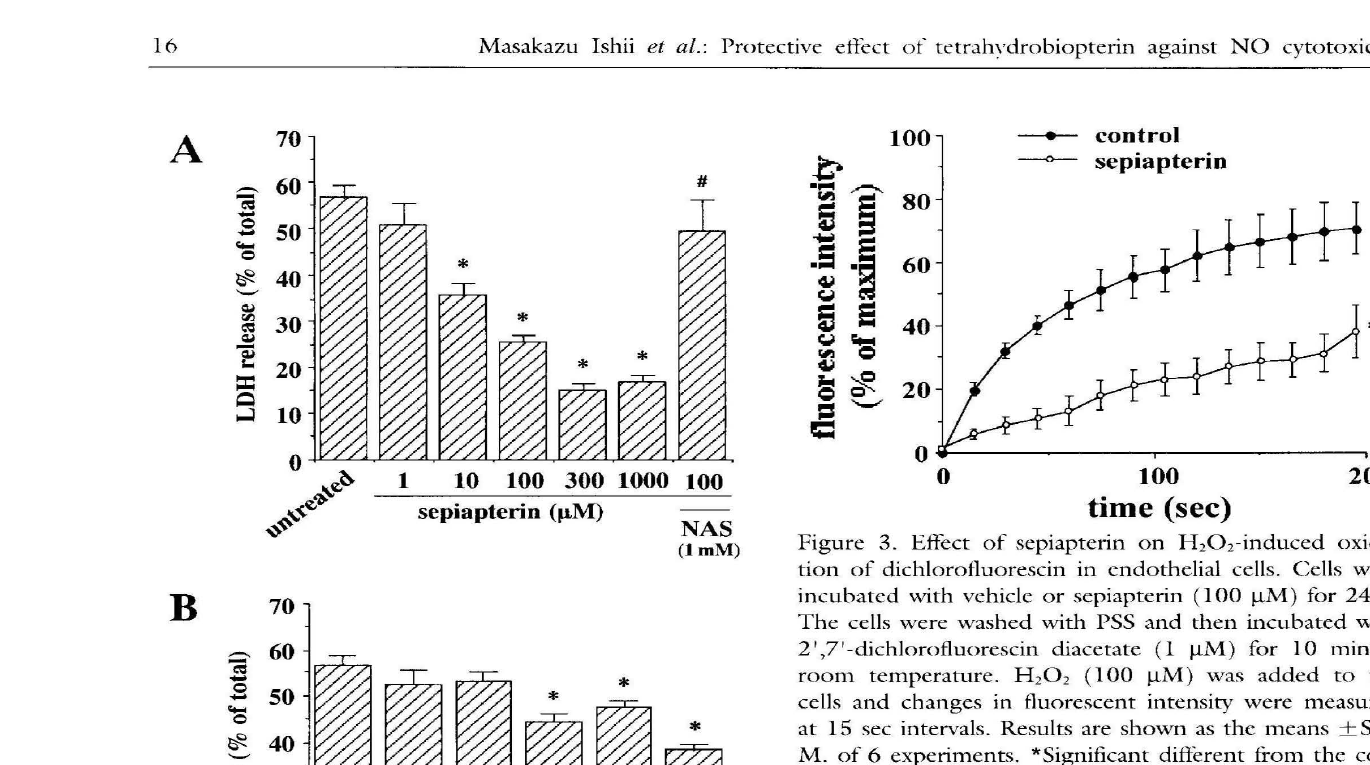
Figure 3. Effect of sepiapterin on H 2 0 2 -induced oxida tion of dichlorofluorescin in endothelial cells. Cells were incubated with vehicle or sepiapterin (1 00 ~M) for 24 h. The cells were washed with PSS and then incubated with 2 ' ,7'-dichlorofluorescin diacetate (1 ~M) for 10 min at room temperature. H 2 0 2 (100 ~M ) was added to the cells and changes in fluorescent intensity were measured at 15 sec intervals. Results are shown as the Ineans